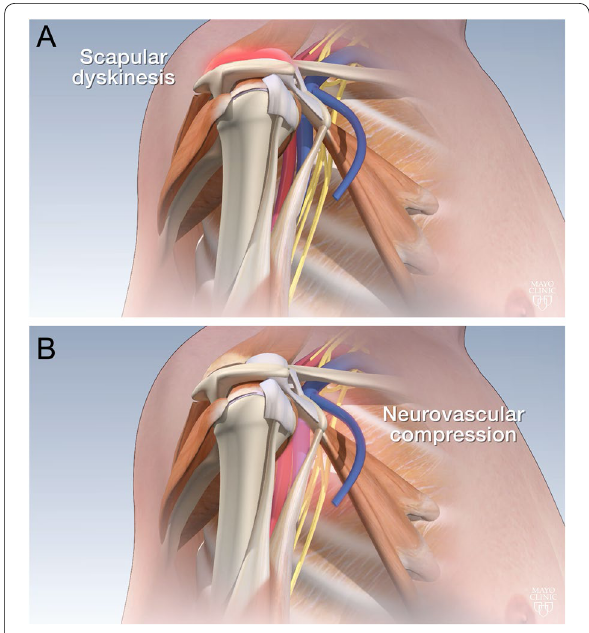
Fig. 1 Pathologic contracture of the pectoralis minor muscle may lead to scapular dyskinesis ( A ) and/or neurovascular compression ( B